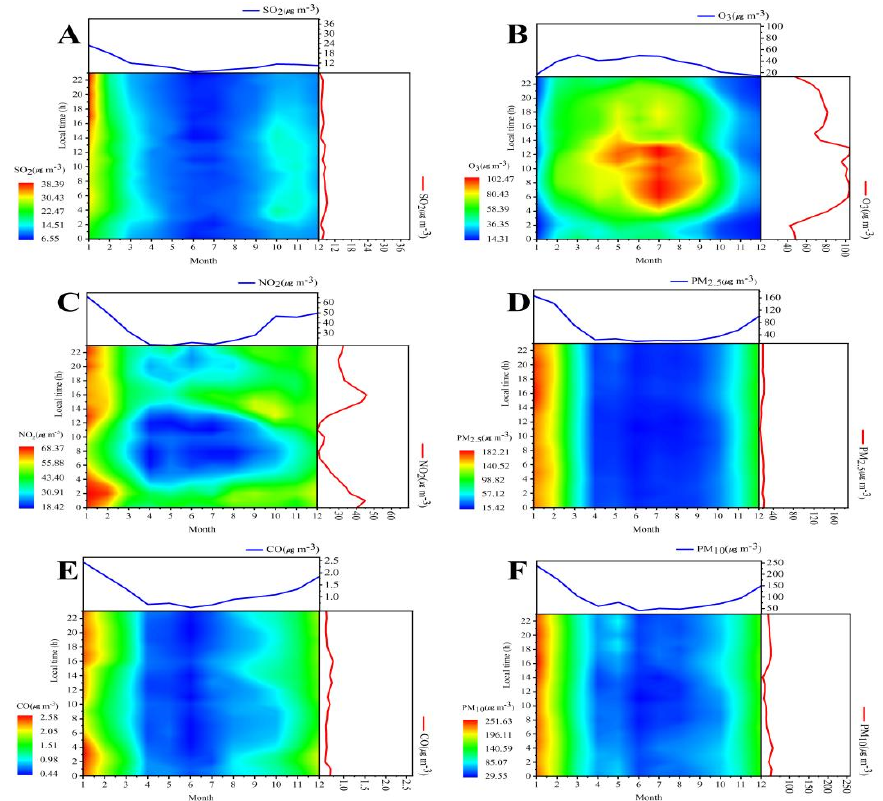
Figure 3. Changji time-dependent distribution of gas concentrations ( A ) SO 2 , ( B ) O 3 , ( C ) NO 2 , and ( E ) CO) and particulate matter ( D ) PM 2.5 and ( F ) PM 10 ). ( μ g m − 3 ).